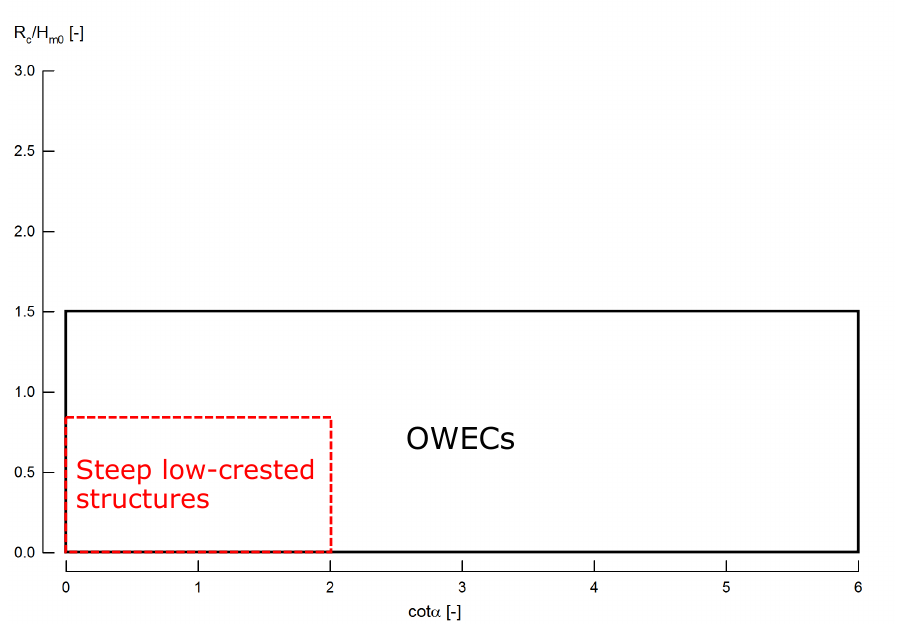
Figure 1. Range of slope angles α and relative crest freeboards R c / H m 0 for OWECs according to Victor and Troch [10] and steep low-crested